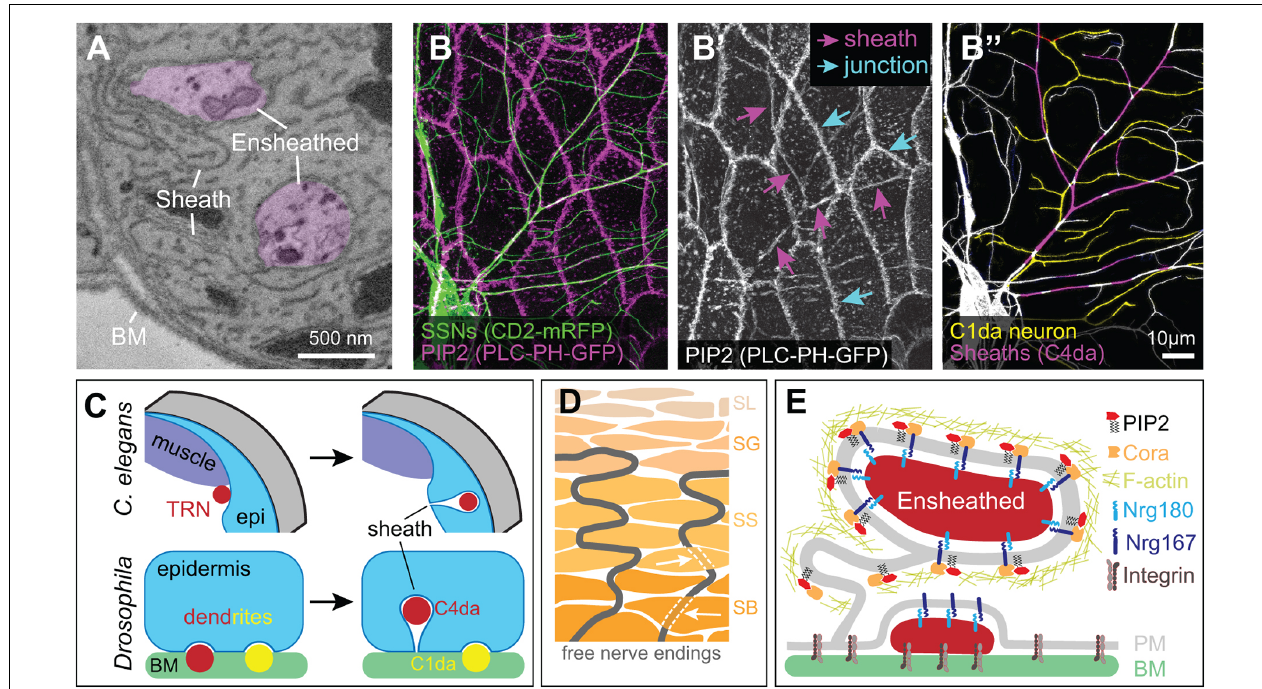
FIGURE 4 | Ensheathment of SSN neurites by epidermal cells. (A) Serial block face scanning electron microscopy micrograph depicting ensheathed (purple) dendrites innervating the Drosophila larval epidermis. (B) Confocal micrograph depicting epidermal ensheathment of Drosophila SSNs. In this image, SSNs are labeled with a membrane-targeted fluorescent protein (green) and epidermal PIP 2 -positive lipid microdomains are labeled by PLC δ -PH-GFP (magenta), which accumulate at epidermal cell-cell junctions (cyan arrows) and at epidermal sheaths (magenta arrows) (B’) . (B”) Ensheathed and unensheathed dendrites often occupy overlapping lateral domains, and this is illustrated by the ensheathment of C4da dendrites (magenta) at sites of overlap with C1da dendrites (pseudo-colored yellow). (C) Developmental sheath assembly in C. elegans and Drosophila . TRN axons (ALM, PLM) are situated adjacent to dorsal muscle at the L1 stage, but following epidermal rearrangement in the L4 stage, the skin ensheaths TRN axons. Drosophila SSN dendrites grow on the basal surface of epidermal cells during embryonic and early larval development. Dendrites from a subset of these neurons (primarily dendrites of C4da neurons, indicated in red) induce membrane invagination and epidermal sheath assembly in third instar larvae. By contrast, unensheathed dendrites (yellow) remain at the basal epidermal surface. (D) Free nerve endings in human skin form cytoplasmic tunnels oriented perpendicular to the skin surface (indicated by white arrows) in keratinocytes within the stratum basale (SB) and stratum spinosum (SS) layers before arborizing within the stratum granulosum (SG; Talagas et al., 2020b). (E) Molecular components of Drosophila epidermal sheaths. Image credits: images in (A–C) are adapted from Jiang et al. (2019) under the Creative Commons